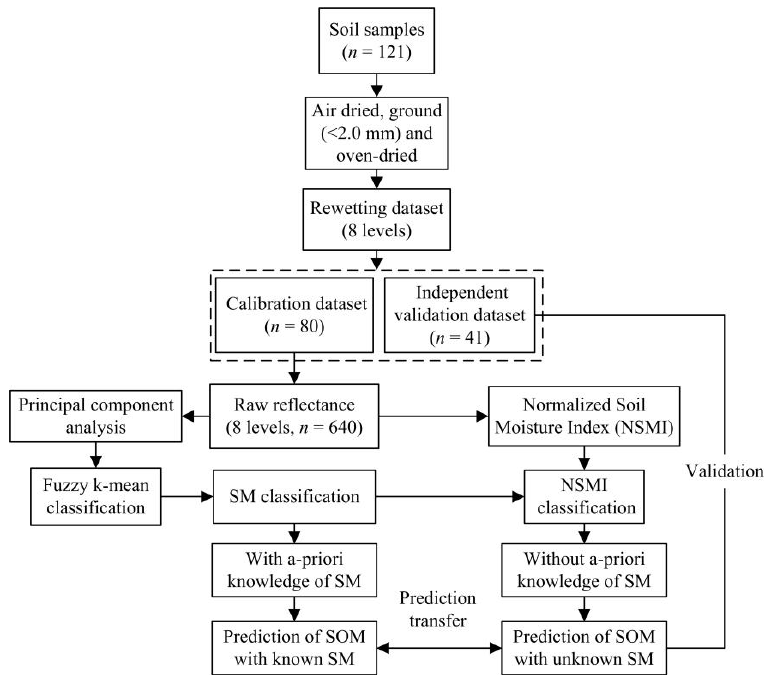
Figure 2. The flow chart of two classification methods (SM–based cluster method and NSMI–based cluster method) for SOM estimation at different SM levels in this study. n : the number of soil samples, same as below.